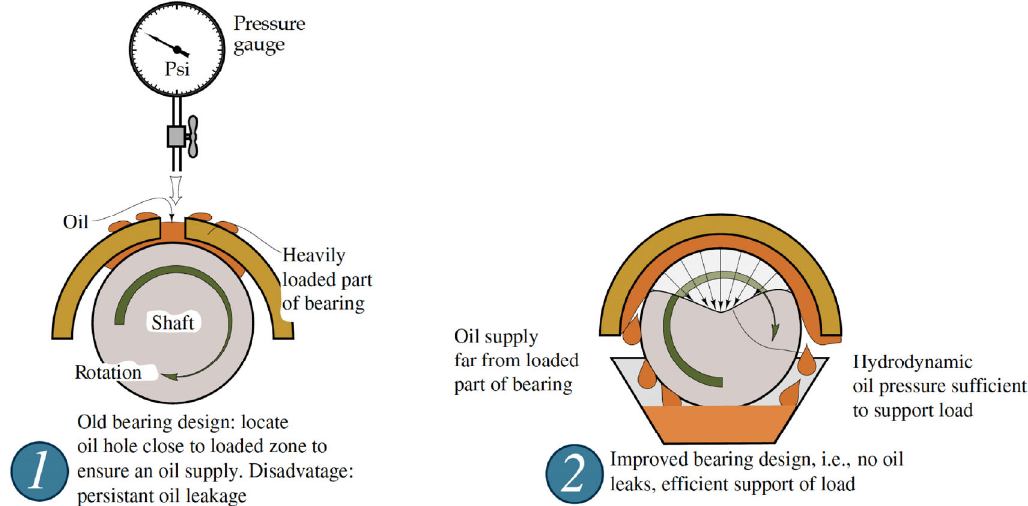
Fig. 1 Discovery of hydrodynamic lubrication in axle bearing (adapted from Ref.